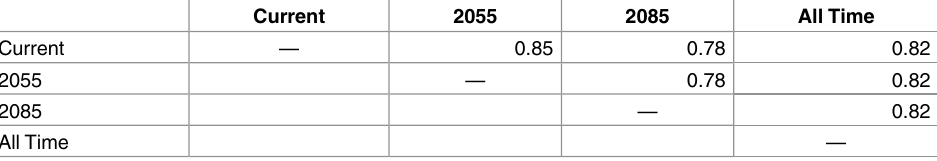
Table 1. The proportion overlap of the highest ranking cells ( > top 25%) of each of the solutions.